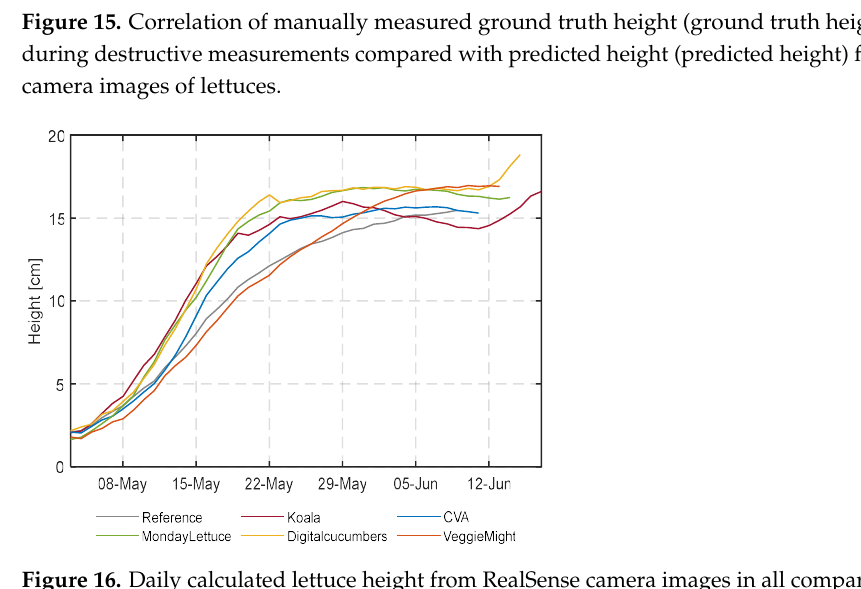
Figure 15. Correlation of manually measured ground truth height (ground truth height) of lettuces during destructive measurements compared with predicted height (predicted height) from RealSense camera images of lettuces.